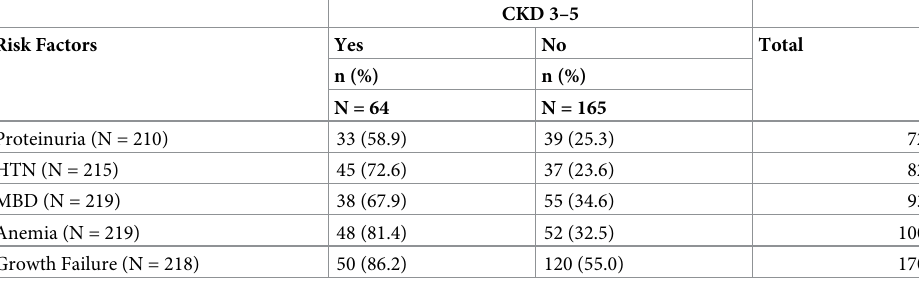
Table 5. Prevalence of manifestations of late-stage CKD in our